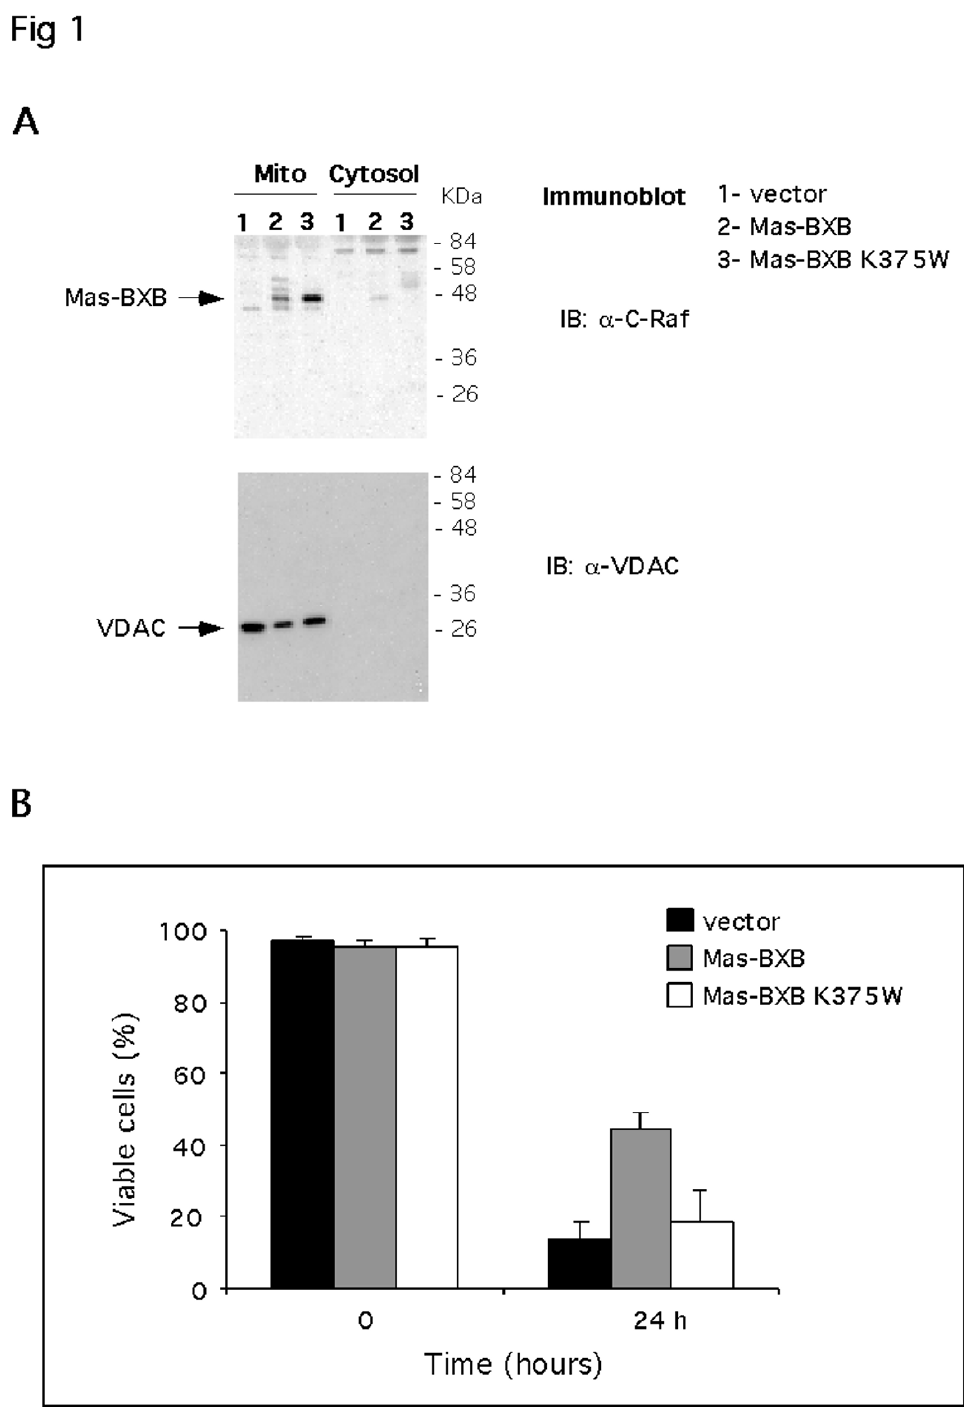
Figure 1 C-Raf modulates the mitochondrial membrane potential during apoptosis . A. Overexpression of C-Raf kinase in 32Dcl.3 cell lines. 32Dcl.3 cells expressing Mas-BXB fusion protein were maintained in IL3-containing medium. Expression of constitutively active Mas-BXB and inactive Mas-BXB K375W proteins was detected in mitochondrial but not cytosolic fractions using an anti-C-Raf antibody. Cell viability of 32Dcl.3 cell lines. 32Dcl.3 transfected cells were cultured without IL-3 for 24 hours and % viable cells was determined by trypan